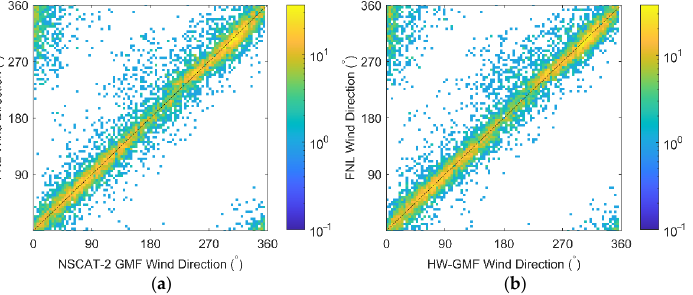
Figure 12. Scatter plots of the wind direction retrieved by the NSCAT ‐ 2 and HW ‐ GMF and the FNL